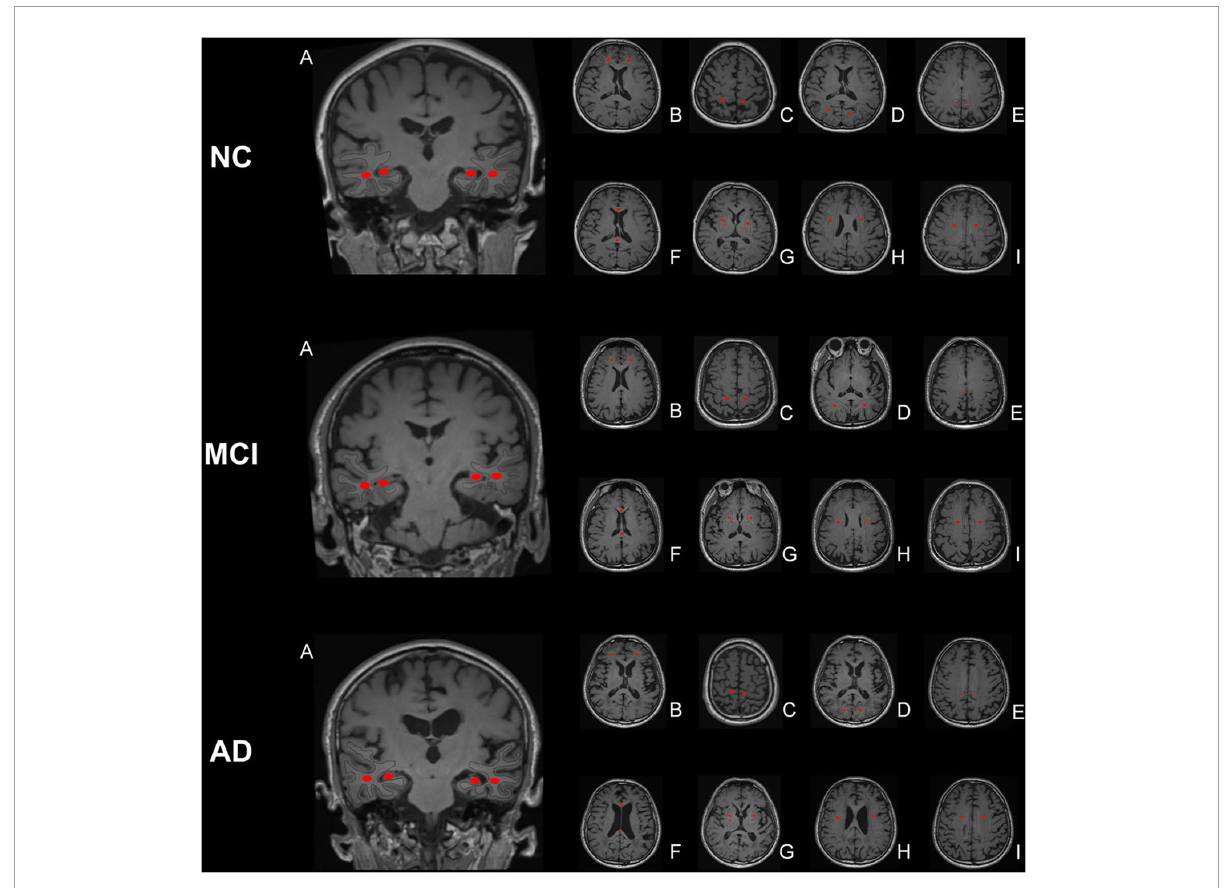
FIGURE2 Region of interest (ROI) placement diagram. The selected ROIs are shown on the T1 maps. (A) temporal lobe and hippocampus; (B) frontal lobe; (C) parietal lobe; (D) occipital lobe; (E) precuneus; (F) splenium of the corpus callosum and genu of the corpus callosum; (G) posterior limb of the internal capsule and lenticular nucleus; (H) corona radiata; (I) centrum semiovale. The central part of the largest layer and the upper and lower adjacent layers of the structure were selected, and the same sized ROIs were drawn in the symmetrical region of the bilateral